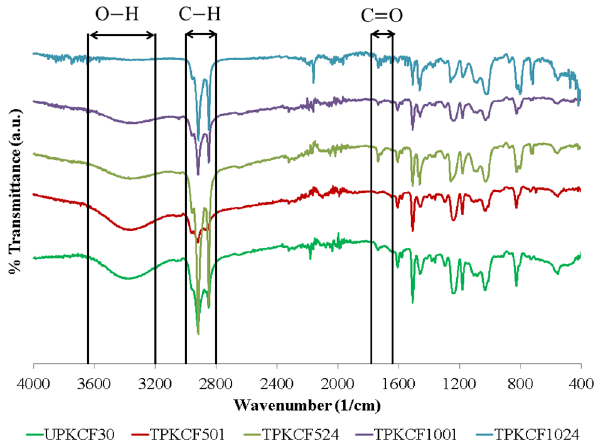
Figure 10. FTIR spectra of untreated and treated PKCF/ER